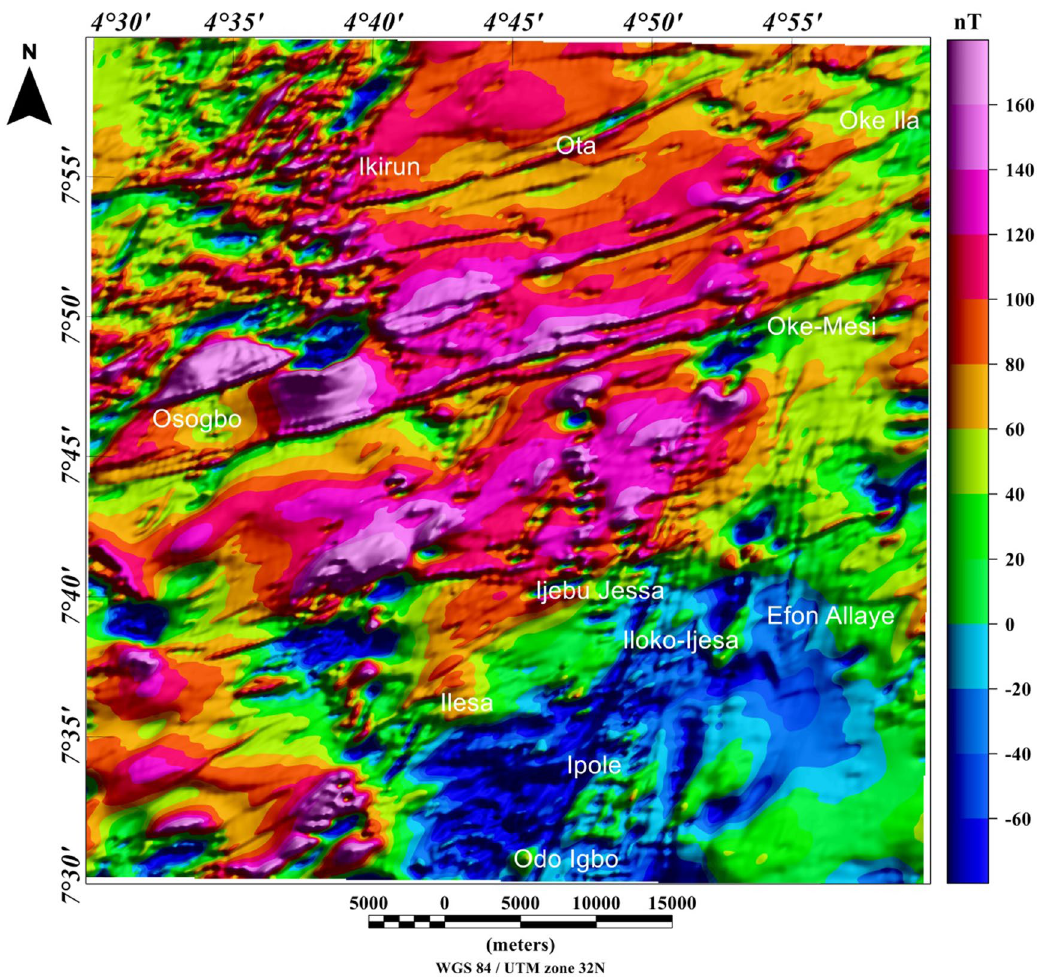
region amplitudes of anomalies resulting from magnetic sources changes from high to low values. The figure was produced using Oasis Montaj Software version 8.3.3 (Website: https:// www. seequ ent.